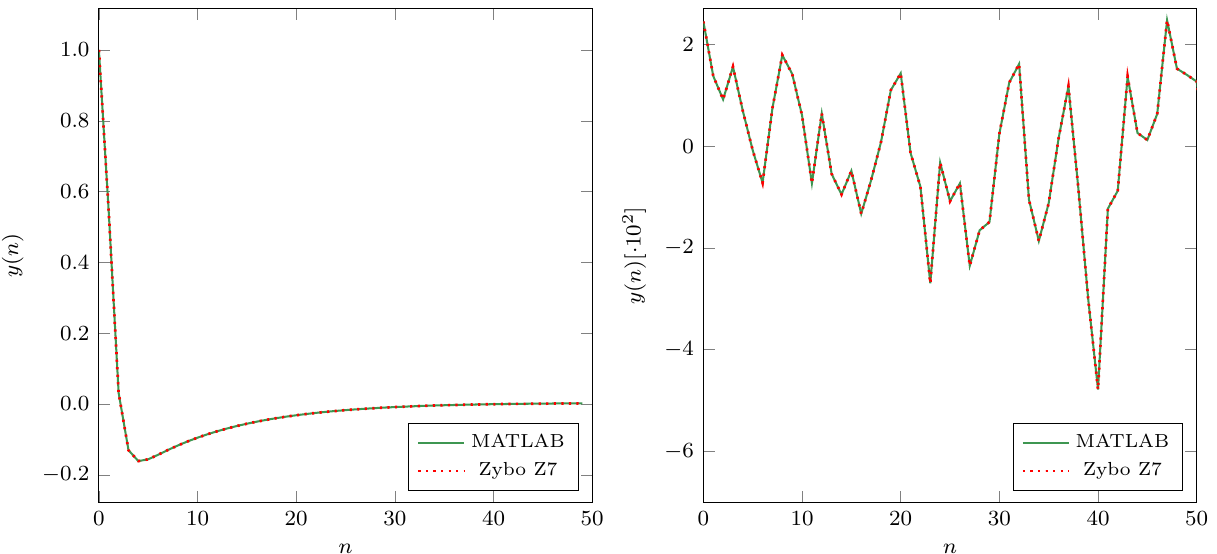
Figure 13. Filter’s outputs from the Zync 7000 SoC and of the MATLAB model for two different inputs. Left : response to the impulse signal; Right : response to